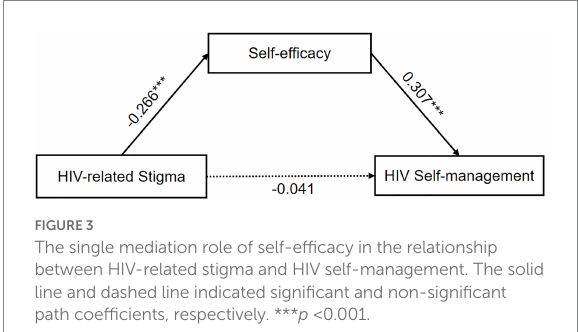
FIGURE 3 The single mediation role of self-efficacy in the relationship between HIV-related stigma and HIV self-management. The solid line and dashed line indicated significant and non-significant path coefficients, respectively. *** p < 0.001.